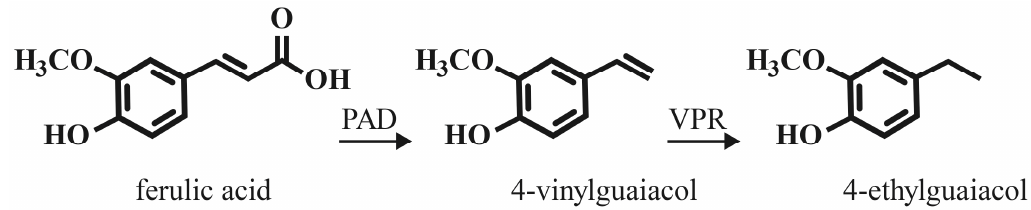
Figure 2. Enzymatic conversion of hydroxycinnamic acid (ferulic acid). PAD, phenolic acid decarboxylase; VPR, vinylphenol reductase.